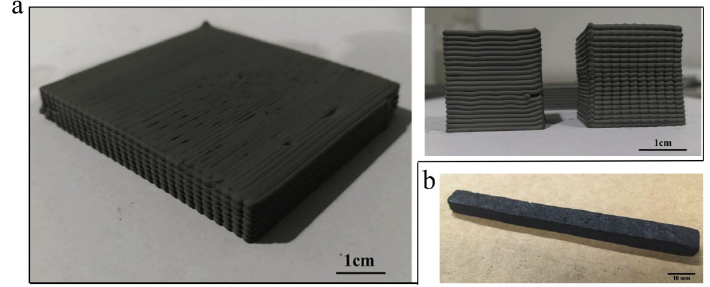
Fig. 22 EFF of SiC ceramic: (a) Work published by Zhang et al . Reproduced with permission from Ref. [72], © Elsevier Ltd and Techna Group S.r.l. 2019. (b) Work published by McClain et al . Reproduced with permission from Ref. [73], © Monique Suzanne McClain